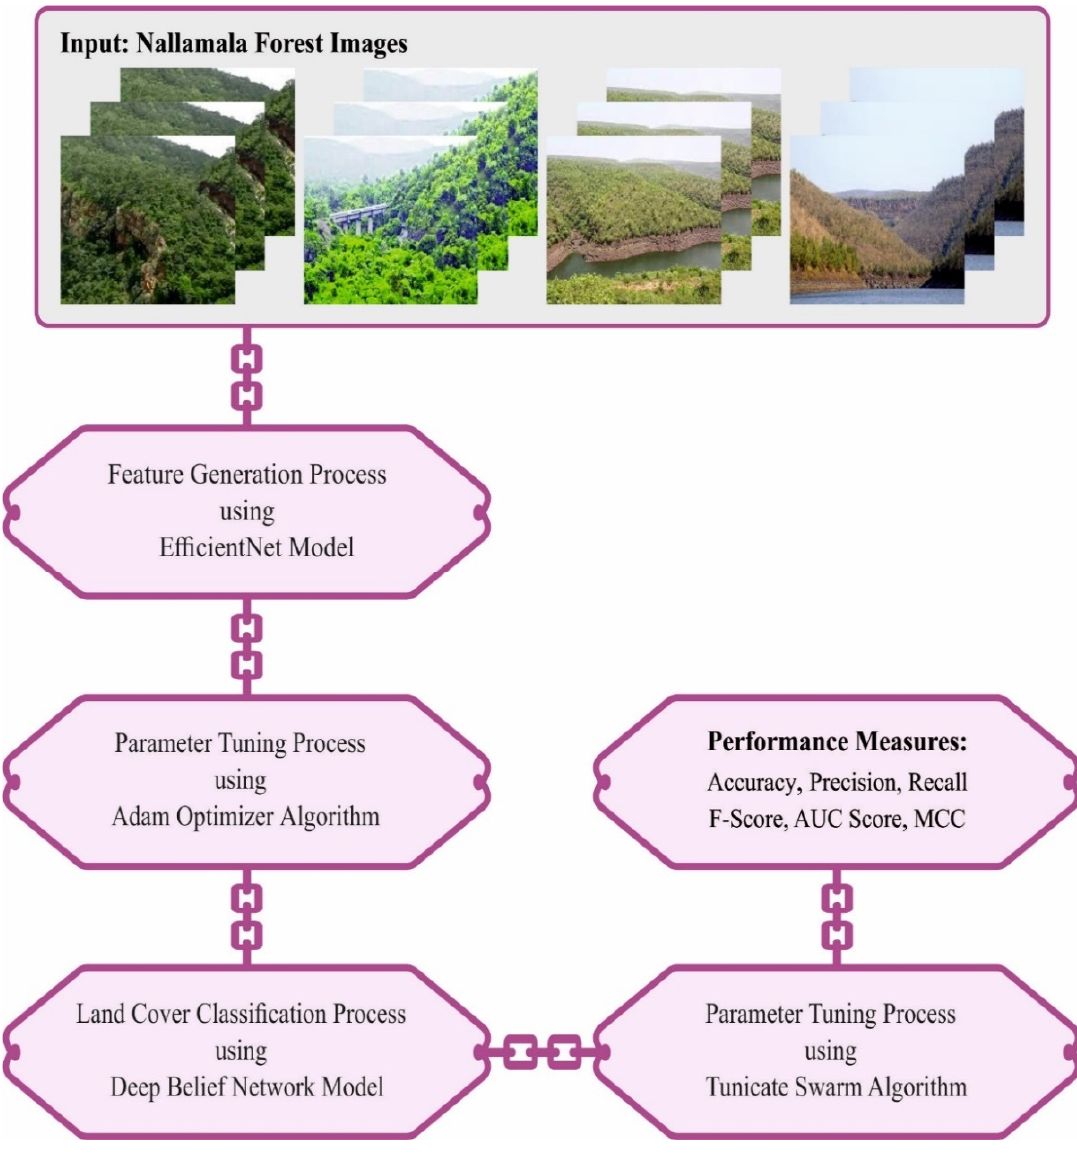
Figure 1. Workflow of TSADL-LULCCD approach.